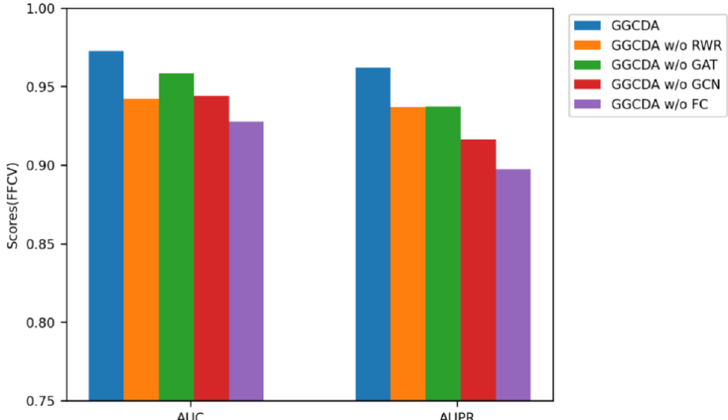
Figure 5. Performance compared with different component.